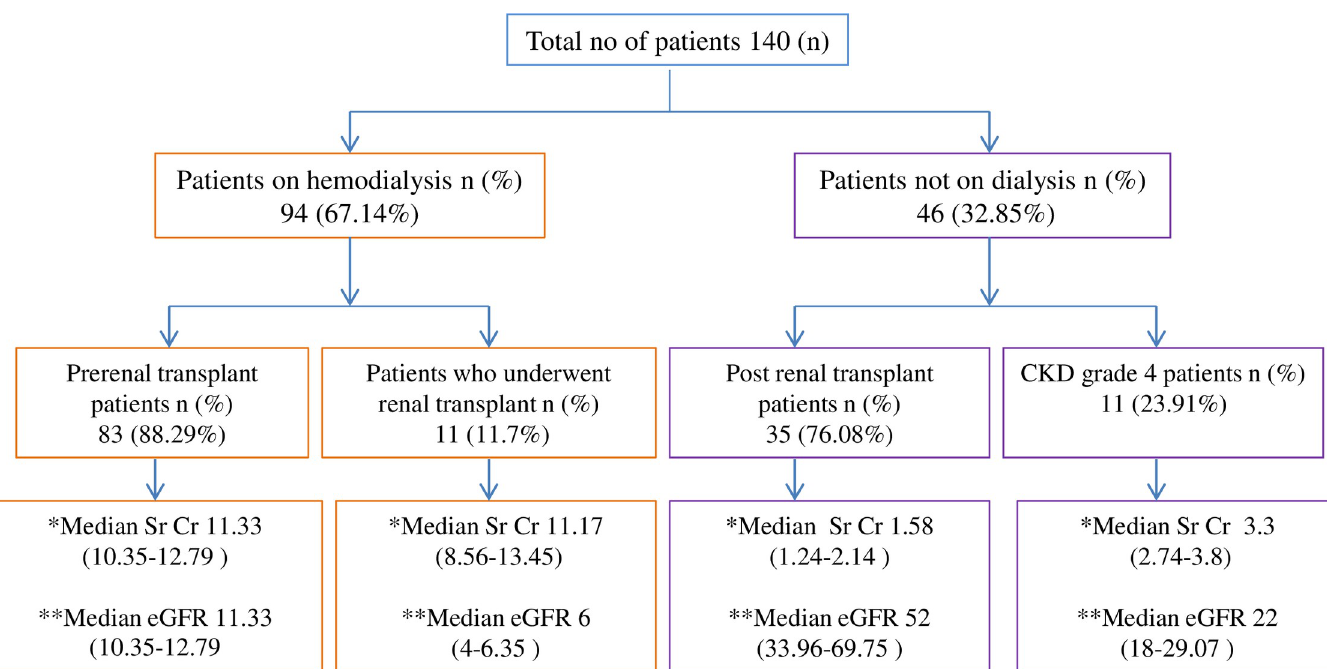
Fig 1. Patients classification with renal function profiles. � Median estimated glomerular filtration rate (eGFR) in ml/min/1.73m 2 with 95% confidence interval (p < 0.0001). �� Median serum creatinine (Sr Cr) in mg/dL with 95% confidence interval (p < 0.0001).